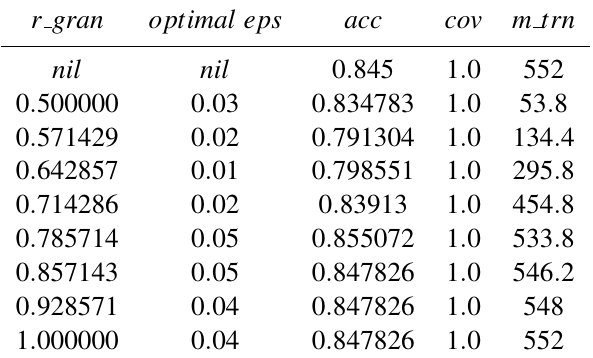
CV-5; Australian credit; Algorithm 5 v3. r gran=granulation radius, optimal eps= optimal epsilon, acc= accuracy, cov=coverage, m trn=mean training set